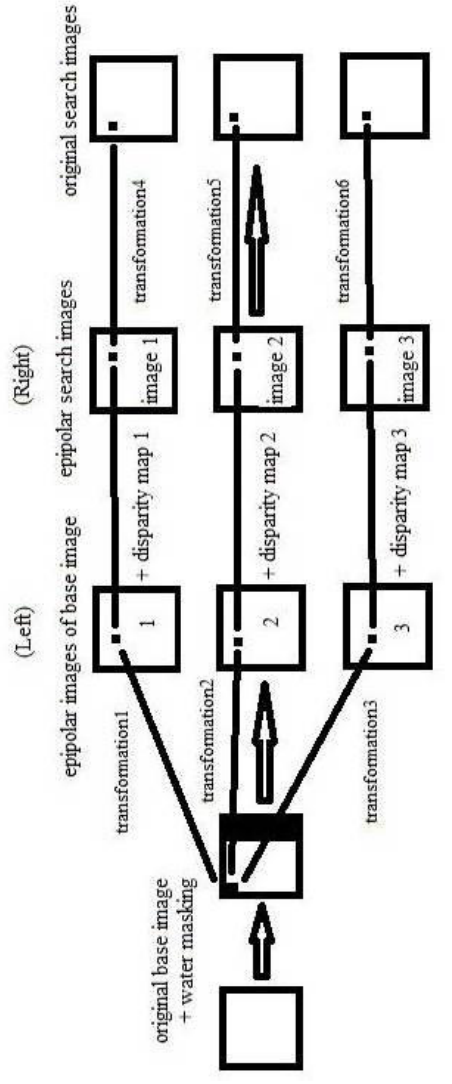
Figure 2. Multi-image matching process for one